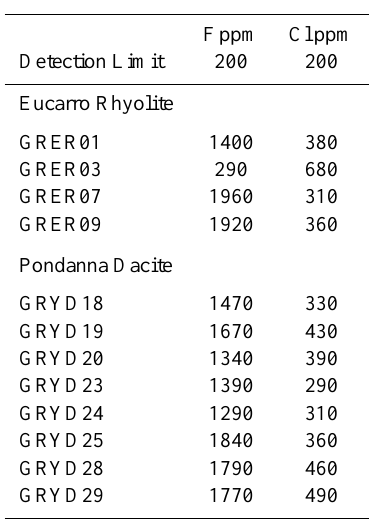
Table 1. Measured (XRF) halogen concentrations for the Eucarro Rhyolite and Yardea Dacite. Note values are likely to be minimum measurements due to devolatilisation and degassing during erup- tion.